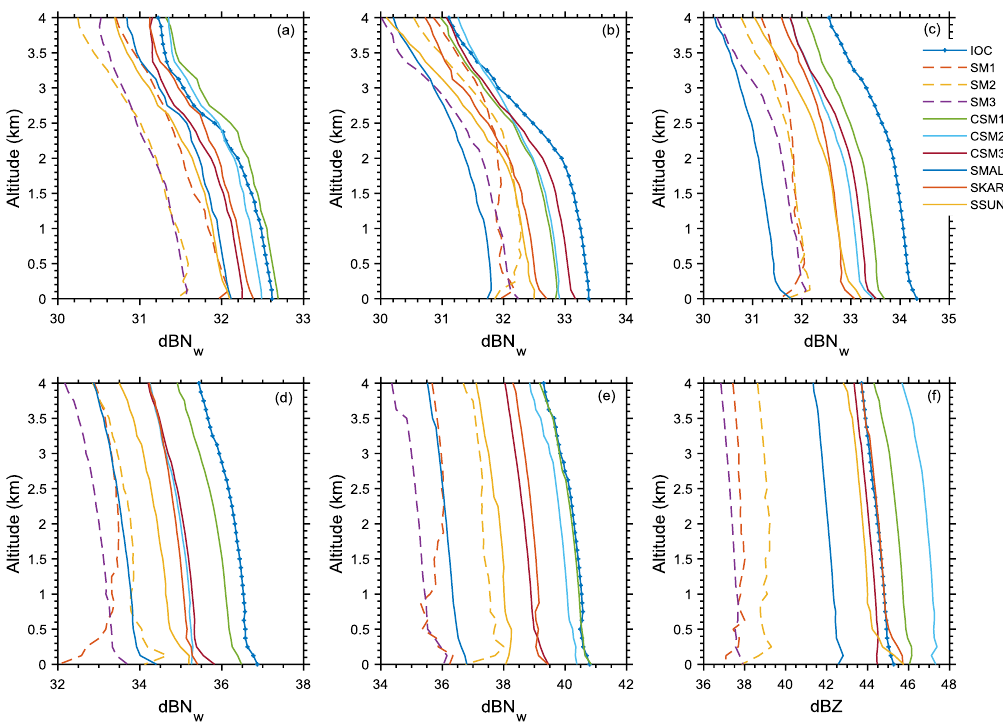
Figure 9. Vertical profile of total drop concentration (dB N w, ) for ten selected locations of convective rain for a) very light rain, b) light rain, c) moderate rain, d) heavy rain, e) very heavy rain, and f) extreme